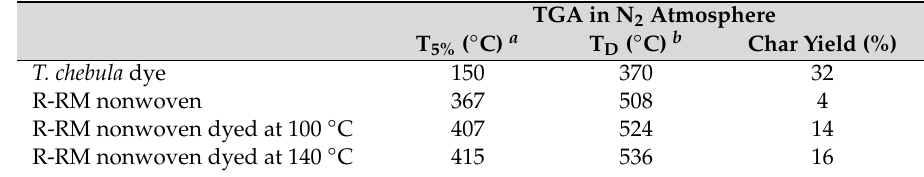
Table 4. Thermal degradation parameters of the T. chebula dye and dyed R-RM nonwoven.